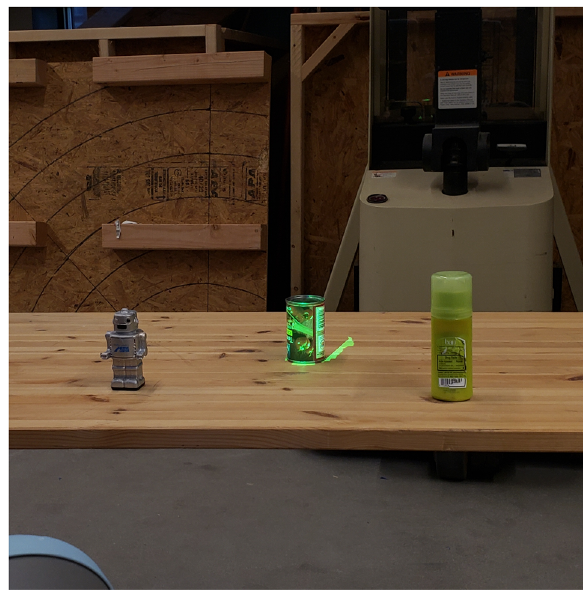
Figure 10: Projector being used to highlight an object in the world. Here it is shown highlighting an object that has been selected by the